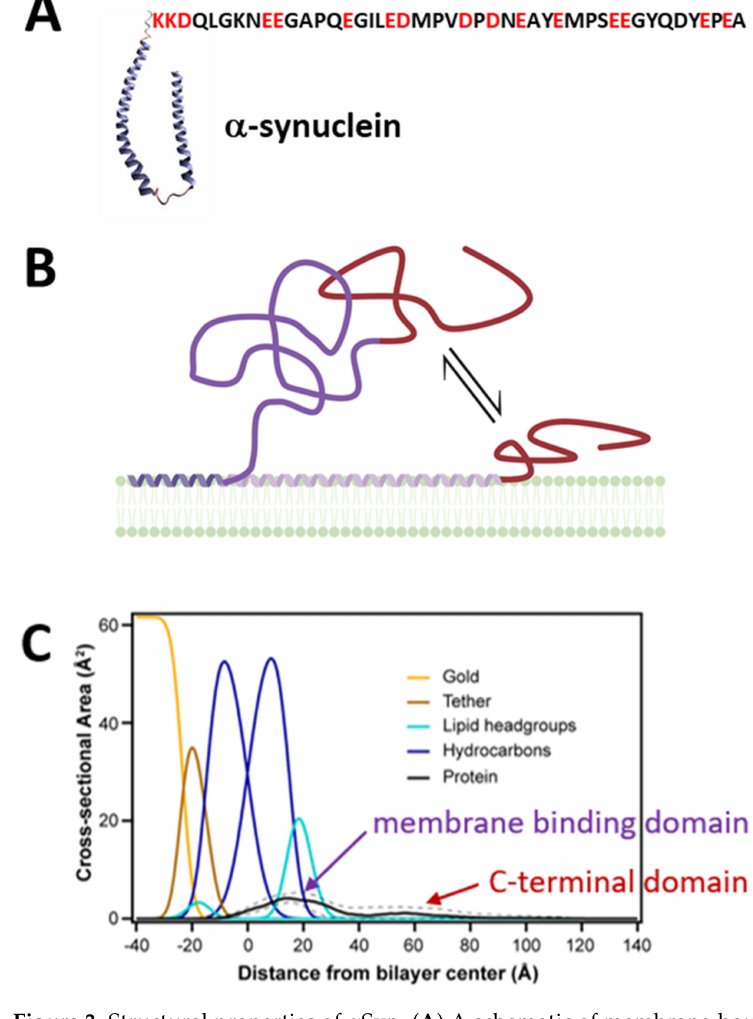
Figure 3. Structural properties of α Syn. ( A ) A schematic of membrane-bound α Syn with its helical N-terminal membrane-binding domain and its disordered C-terminal domain shown as the amino acid sequence (PDB ID: 1XQ8). ( B ) α Syn is peripherally membrane-bound and fluctuates between conformations where the C-terminal domain (red) is pinned close to, or floats further above, the membrane surface. Created with Biorender.com (accessed on 17 May 2021). ( C ) Volume occupancy of α Syn on lipid membrane surfaces is determined by neutron reflectometry in combination with selective perdeuteration. The membrane-binding domain is localized to the membrane, while the polyanionic C-terminal domain is broadly distributed, suggesting free-motion above the membrane surface. Solid and dashed lines show the median and 68% confidence interval, respectively, of the α Syn volume occupancy. Adapted with permission from Jiang et al., J. Phys. Chem. Lett . (2017). Copyright © 2016 American Chemical